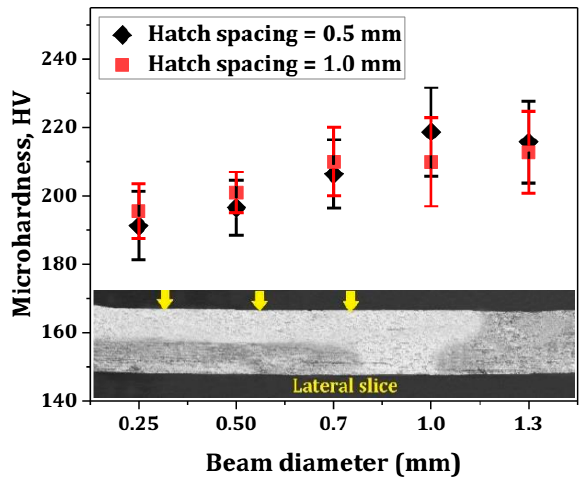
Figure 11. Average microhardnesses of the samples, indented along the scan direction outlined in the lateral slice image.